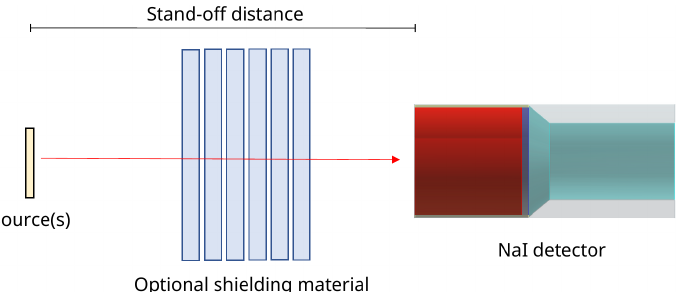
Figure 2. Diagram of the basic test scenario. A 3 (cid:48)(cid:48) × 3 (cid:48)(cid:48) NaI detector was placed 1, 5, and 10 cm from the source, biased to +800 V. The signal was passed through an Ortec 571 amplifier (2 µ s shaping time) and digitised with an Ortec Easy-MCA-8K Multi-Channel Analyser (MCA). Metal plates were placed between the source and detector for